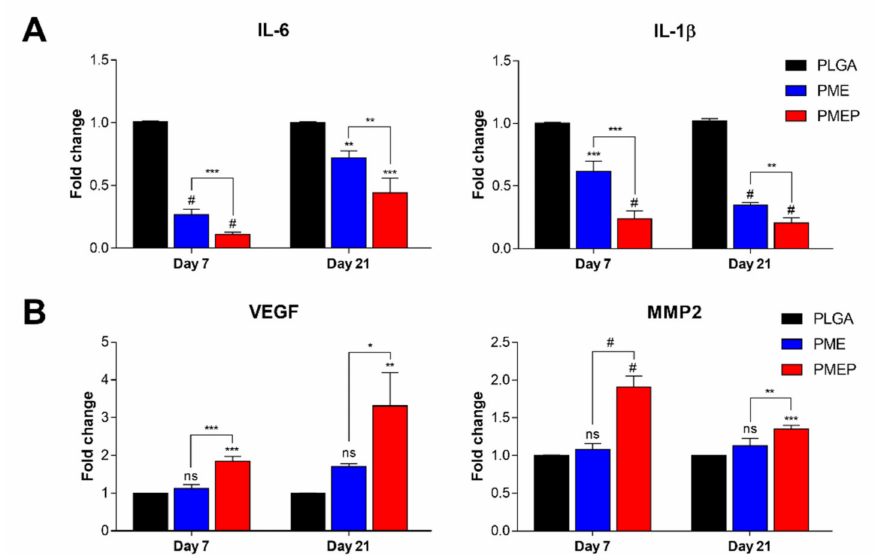
Figure 4. Anti-inflammatory and angiogenic effects on the scaffolds using hBMSCs. Gene expressions of hBMSCs onto the scaffolds related to ( A ) anti-inflammation: IL-6 and IL-1 β , and ( B ) angiogenesis: VEGF and MMP2 at 7 and 21 days. The differences were considered significant when ns = not significant ( p ≥ 0.05), * p < 0.05, ** p < 0.01, *** p < 0.001, and # p < 0.0001 ( n ≥